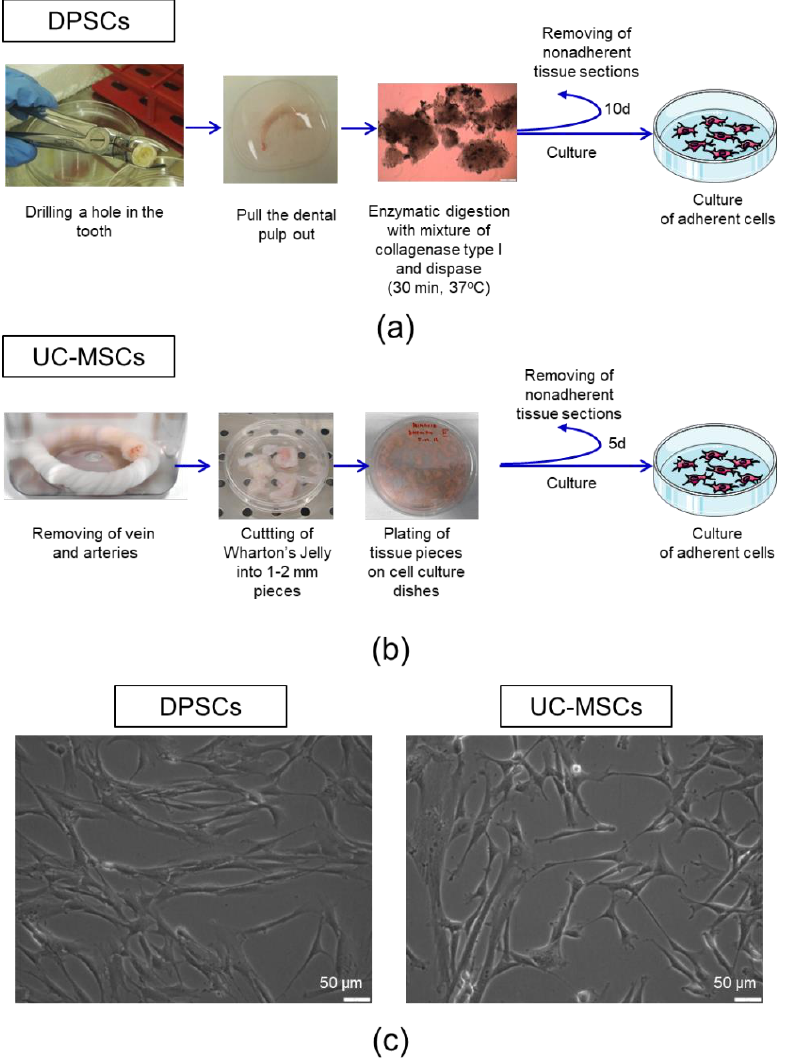
Figure 1. Isolation procedure and morphology of dental pulp stem cells (DPSCs) and umbilical cord Wharton’s jelly-derived mesenchymal stem/stromal cells (UC-MSCs). ( a ) Isolation of DPSCs from pulp tissue. The upper part of the tooth was drilled and the dental pulp was extracted. The dental pulp was enzymatically digested by a mixture of collagenase I and dispase. The isolated cells and tissue sections were seeded onto cell culture plates in a complete cell culture medium. On day 10 post-seeding, non-adherent cells and tissue pieces were removed. ( b ) Isolation of UC-MSCs from Wharton’s jelly. The umbilical cord was washed with PBS to remove residual cord blood, and arteries and vein were further dissected. Wharton’s Jelly tissue was cut into 12 mm pieces and placed on the tissue culture dishes in a complete cell culture medium. On day five post-seeding, non-adherent cells and tissue pieces were removed. ( c ) Representative images of the morphology of DPSCs (left) and UC-MSCs (right). Scale bars: 50 µm.